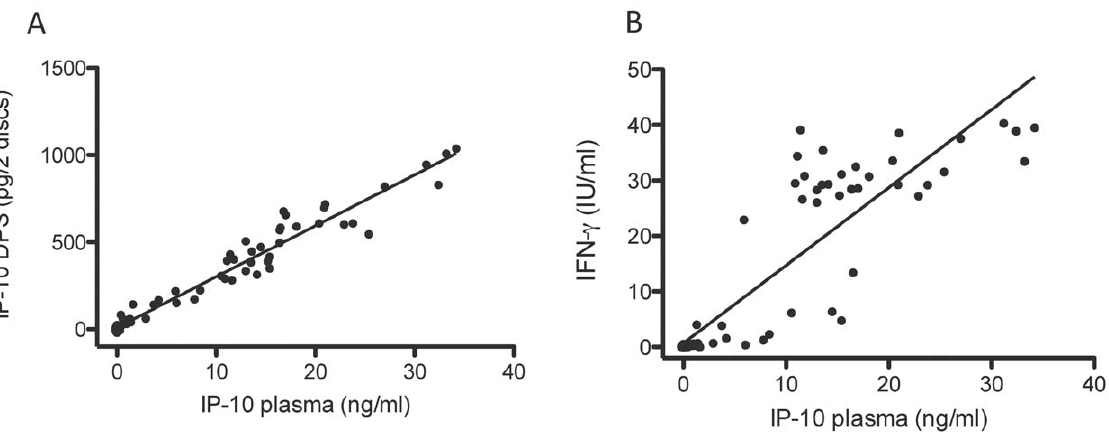
Figure 6. Correlation between IP-10 detected in plasma and DPS (A), and between IP-10 detected in plasma and INF- c detected in plasma (B). A total of 25 healthy donors were compared. Nil, CMV-antigen and mitogen samples were pooled, rendering a total of 75 data-points per graph (Spearman).